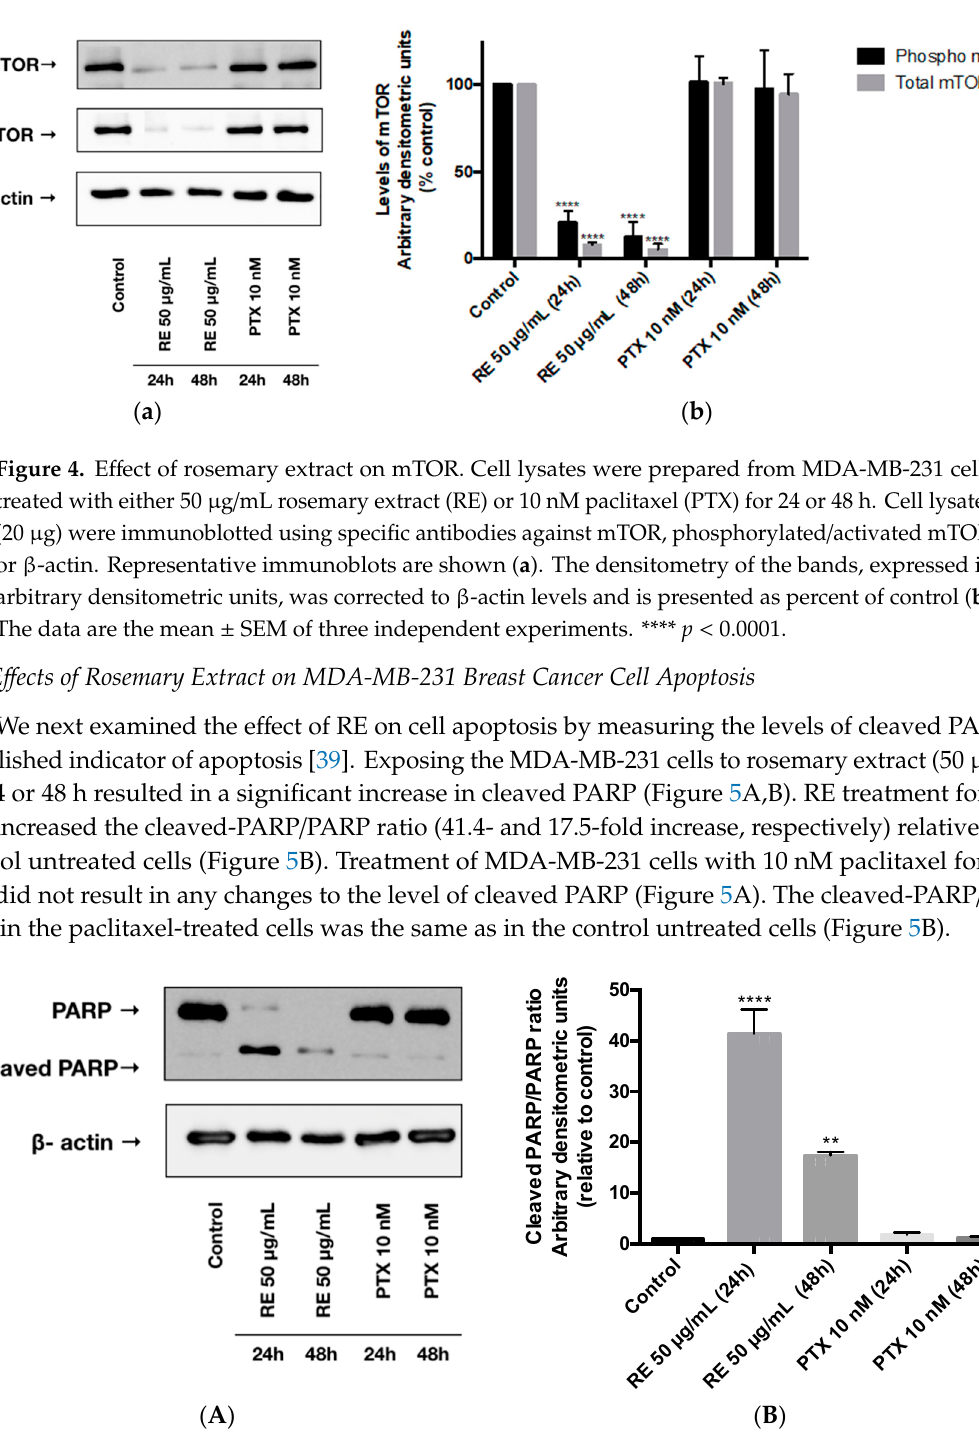
Figure 5. Effect of rosemary extract on PARP. Cell lysates were prepared from MDA-MB-231 cells treated with either 50 µg/mL rosemary extract (RE) or 10 nM paclitaxel (PTX) for 24 or 48 h. Cell lysates (20 µg) were immunoblotted using specific antibodies against PARP or β -actin. Representative immunoblots are shown ( A ). The densitometry of the bands, expressed in arbitrary densitometric units, was corrected to β -actin levels and is presented as a fold increase relative to control untreated cells ( B ). The data are the mean ± SEM of three independent experiments. ** p < 0.01, **** p < 0.0001.